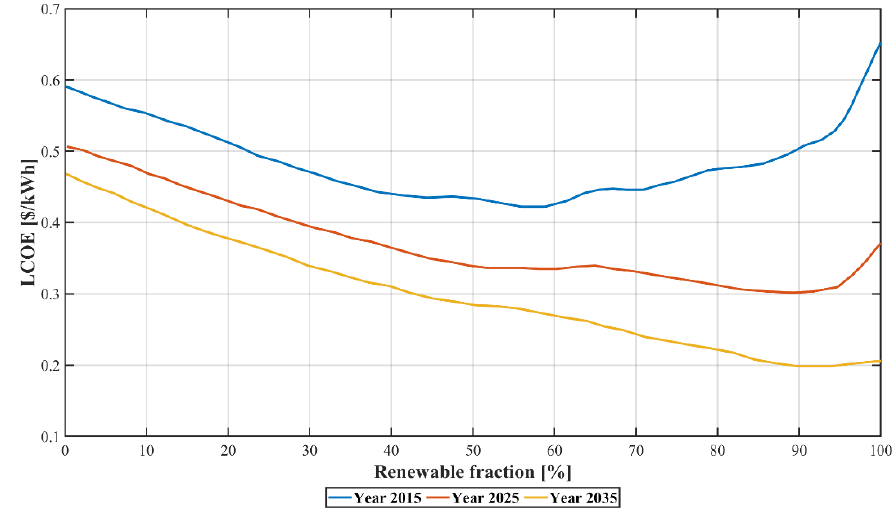
Figure 1. Renewable fraction vs. real levelized cost of energy for 2015, 2025, and 2035 [13].